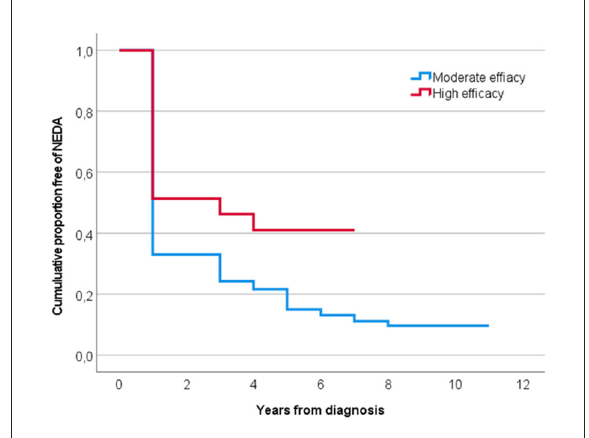
FIGURE4 Years to NEDA fail in pwMS started on moderate (blue) and high (red) efficacy therapy within 6 months. NEDA no evidence of disease activity.